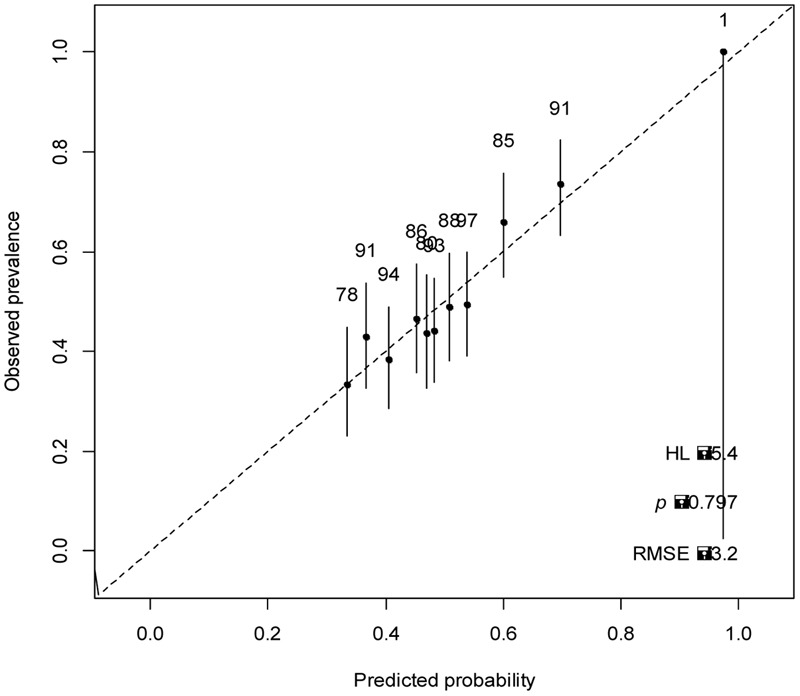
Goodness fit model.